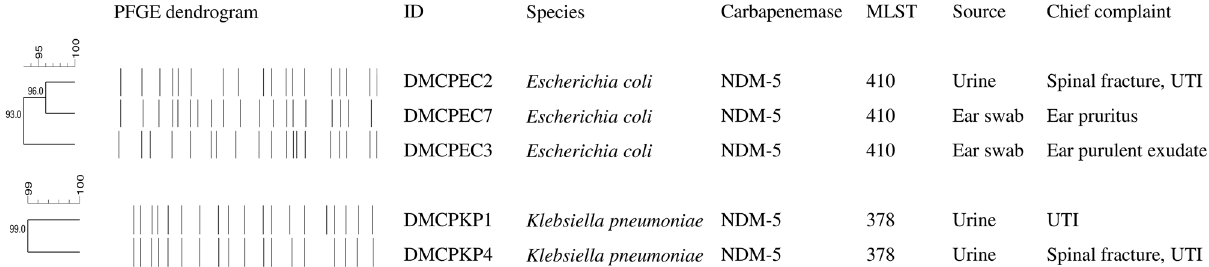
Figure 1. General information of the NDM-5-producing Enterobacterales strains based on patient history, PFGE and MLST data. PFGE patterns were generated and analyzed in Dice similarity coefficient with Unweighted Pair-Group Method with Arithmetic Mean (UPGMA) dendrogram via BioNumerics, version 6.6 (Applied Maths NV,